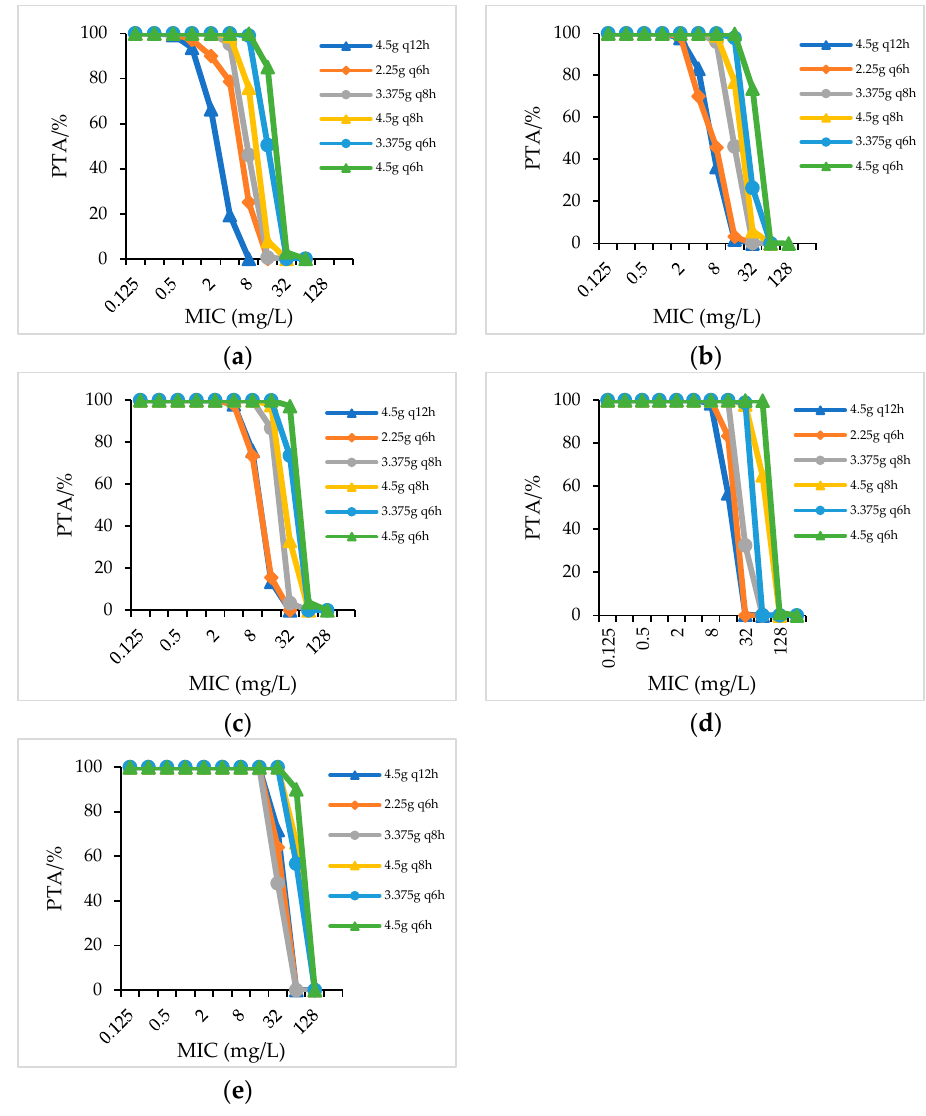
Figure 2. PTA for PTZ in patients with different renal functions. ( a ) CrCL > 90 mL/min; ( b ) CrCL 60–90 mL/min; ( c ) CrCL 40–59 mL/min; ( d ) CrCL 20–39 mL/min; ( e ) CrCL < 20 mL/min.